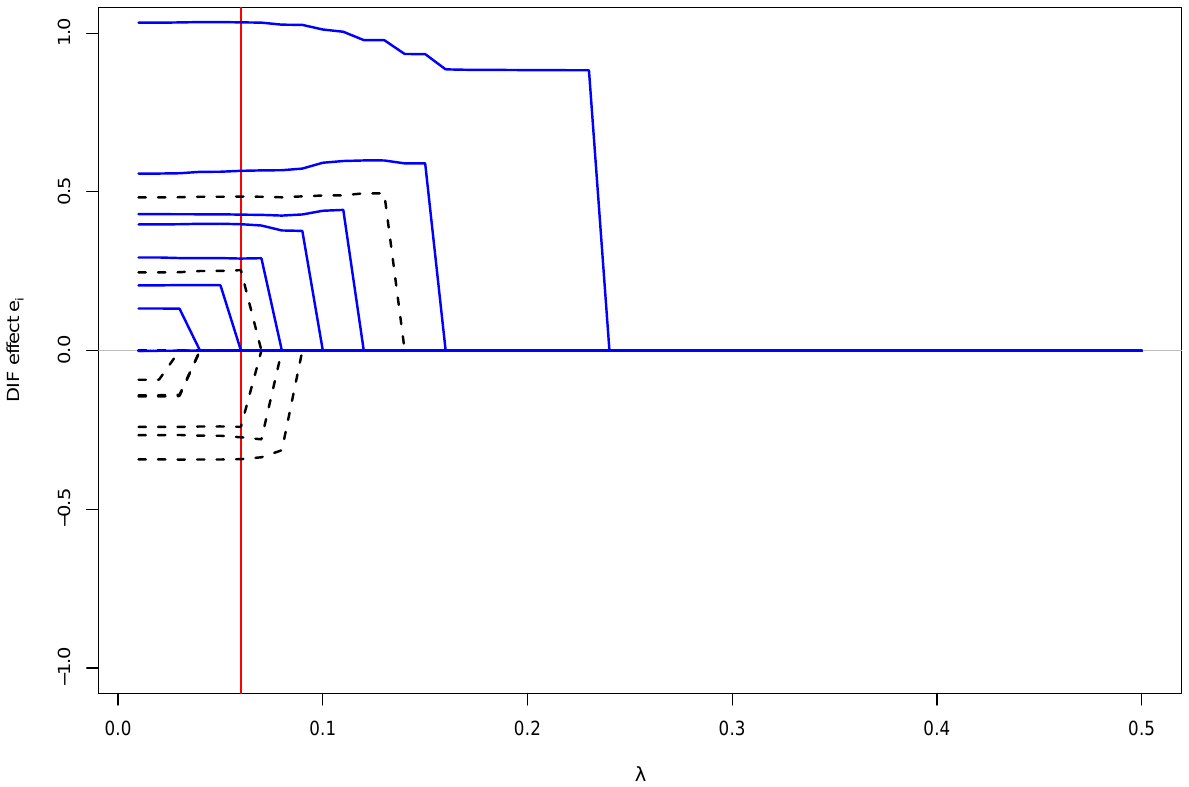
Figure 5. Simulated Case Study 2: AIC as a function of the regularization parameter λ . The red triangle corresponds to the optimale λ value with minimal AIC.